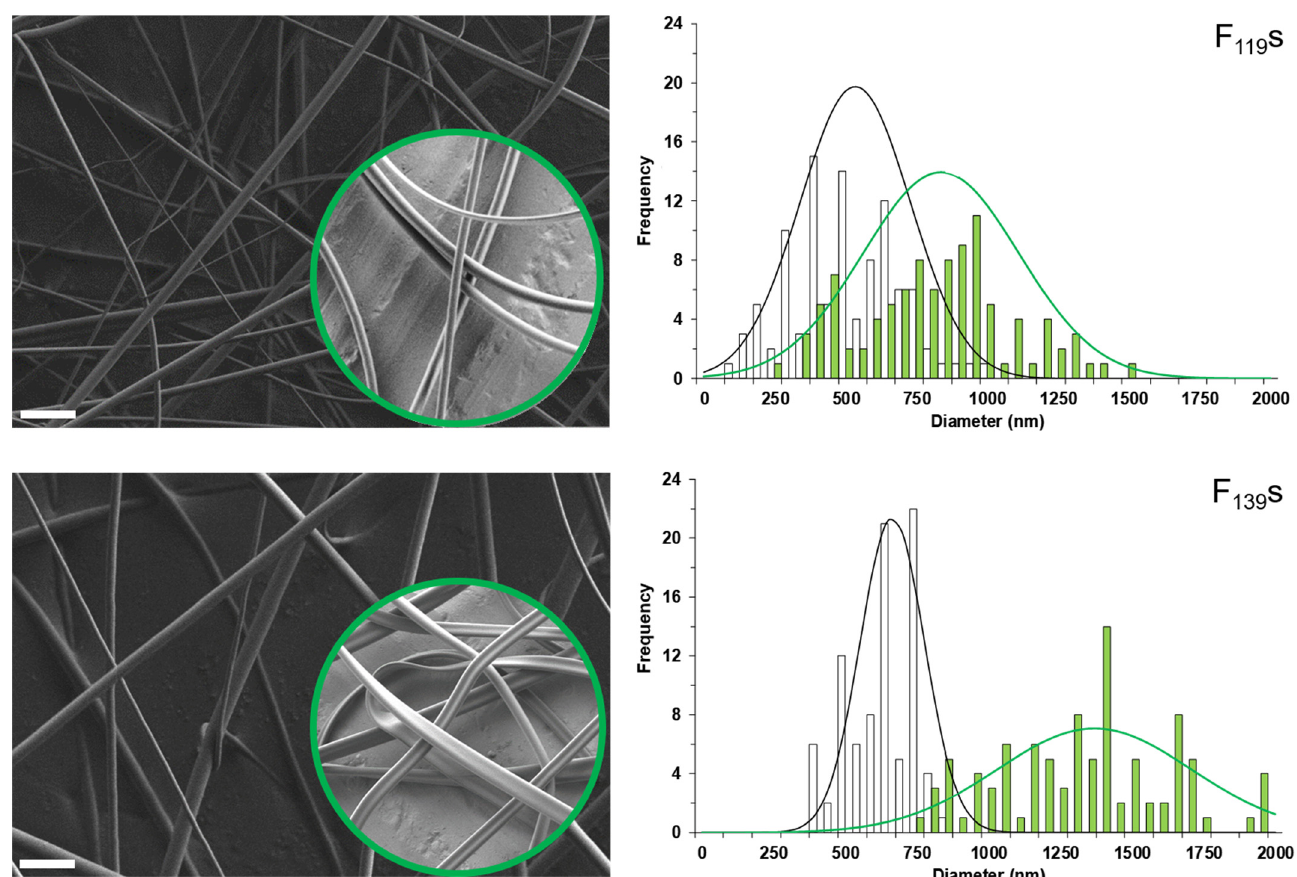
Figure 1. Representative field emission scanning electron microscopy (FESEM) images ( left ) and frequency distribution histograms of the diameter ( right ) of electrospinning-optimized F 119 s and F 139 s. Non-loaded fibers in main images and menthol-loaded ones inside the green-circle insets (scale bars: 5 μ m). Each histogram was performed with the data obtained from several images (at least seven) until reaching 100 measurements (white and green bars correspond to non-loaded and menthol-loaded fibers, respectively). Best-fit adjustments to a Gaussian distribution are also correspondingly indicated with a line.